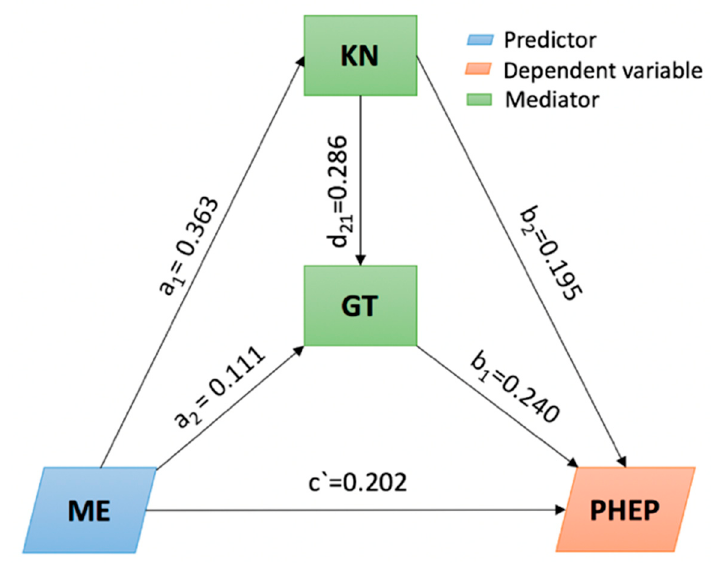
Figure 4. Serial multiple mediating effects of knowledge (KN) and government trust (GT) on the relationship between media exposure (ME) and public health emergency preparedness (PHEP).